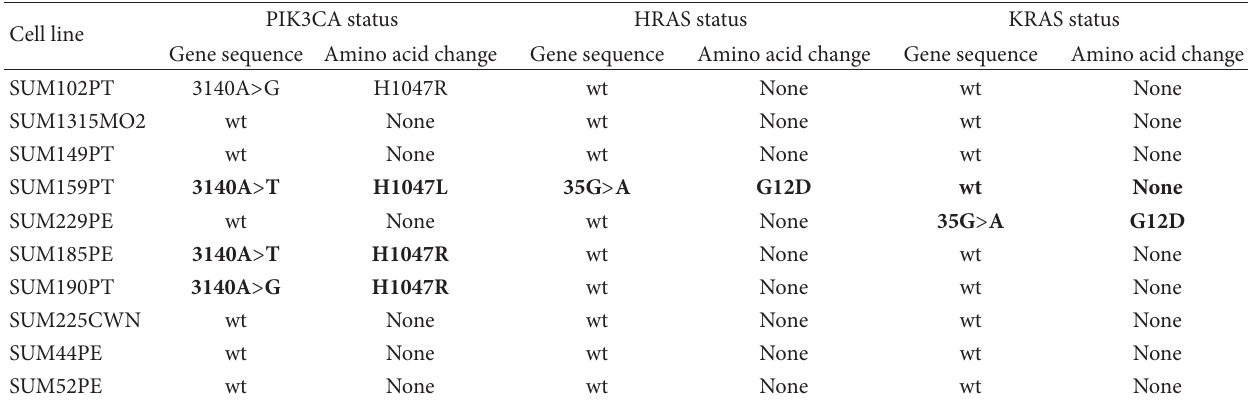
T 5: PIK3CA, HRAS and KRAS mutation status for SUM cell